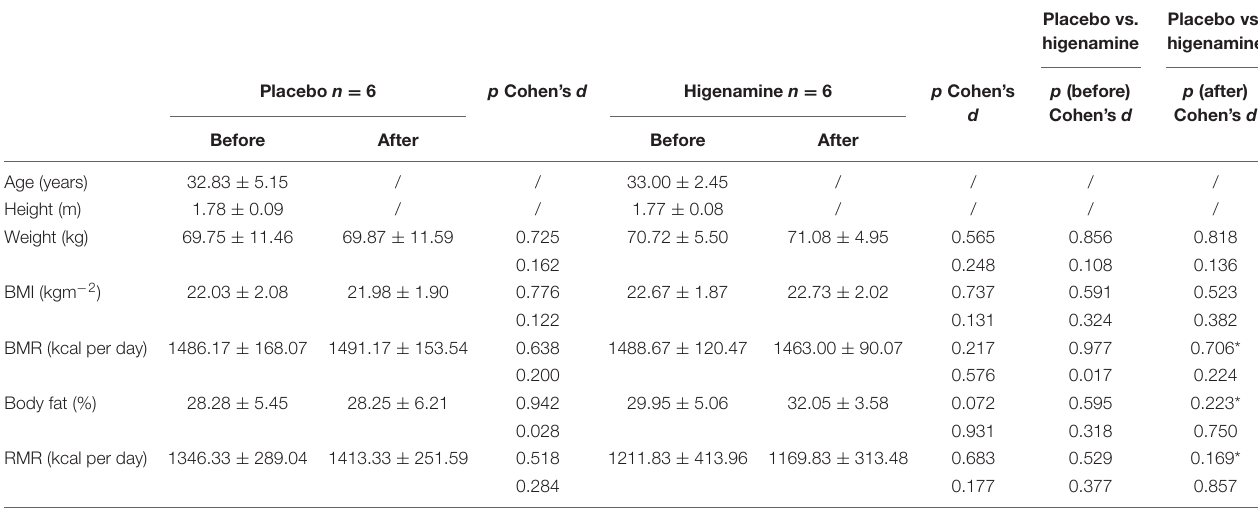
TABLE 1 | Anthropometric characteristics of placebo and higenamine groups before and after the treatment.